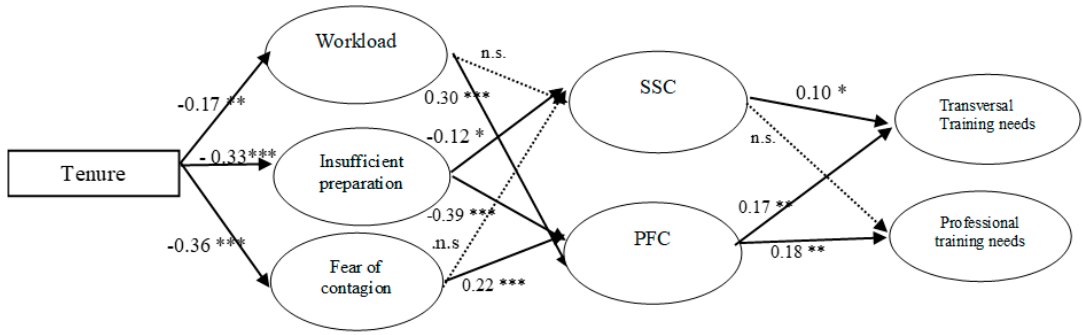
< 0.05; ** p < 0.01; and *** p < 0.001.